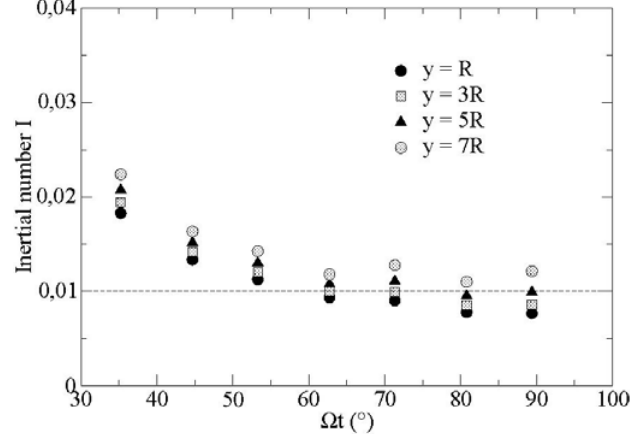
Figure 3. Inertial number I as a function of angular displacement ( x = 33 R, t = 0.015 s, t = 0.015 s, μ = 0.1, μ ’ = 0.2; y = R – 3 R – 5 R – 7 R ).